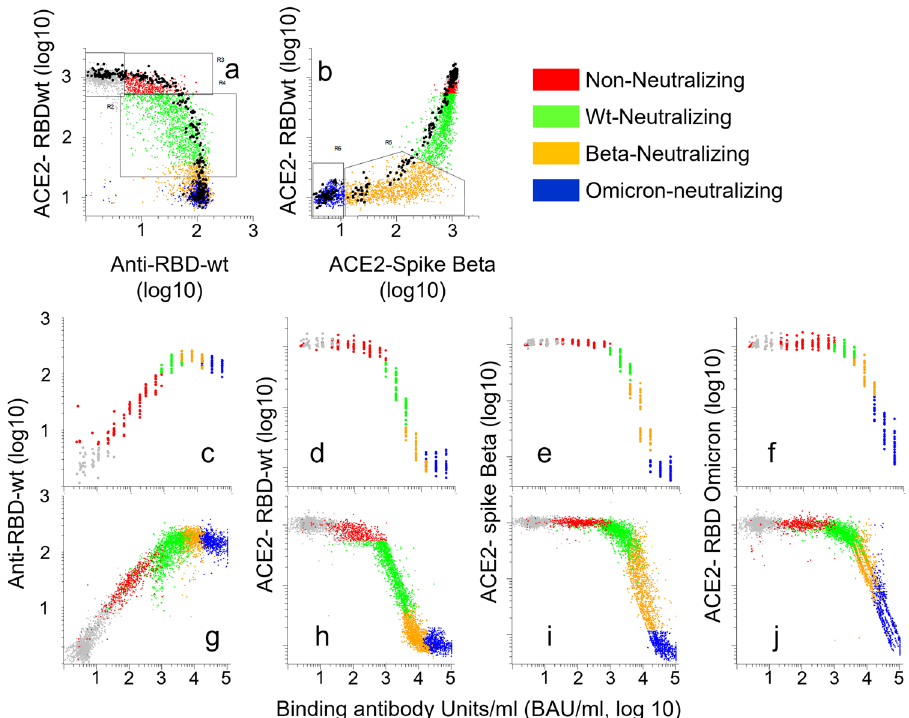
Fig. 7 Groups identi fi ed by multi-IgG-ACE2-RBD correspond to de fi ned ranges of binding antibody units per milliliter (BAU/ml). A total of 6693sera wereanalyzed with multi-IgG-ACE2-RBD together witha standardseries with pre-de fi ned BAU/ml. Each dot in the scatter plotscorrespond to a different sample. a , b See in the legend to Fig. 5a, b, except that the black dots correspond to a standard series prepared by serial dilution of a serum with an anti-RBDwt titer of 53.000 BAU/ml. c – f Results obtained with the standard series in 26 consecutive 384 well plates. The x-axes show BAU/ml calculated from serial dilutions of the standard series. The y -axes show binding of IgG to beads coupled with RBDwt ( c-g,j ), or ACE2 binding to beads coupled with RBDs or spike proteins as indicated. g – j : Results obtained with the standard series were used as input in Excel regression functions to generate formulae for conversion of signals measured for the 6693 sera into BAU/ml (). Source data are provided as a Source Data fi